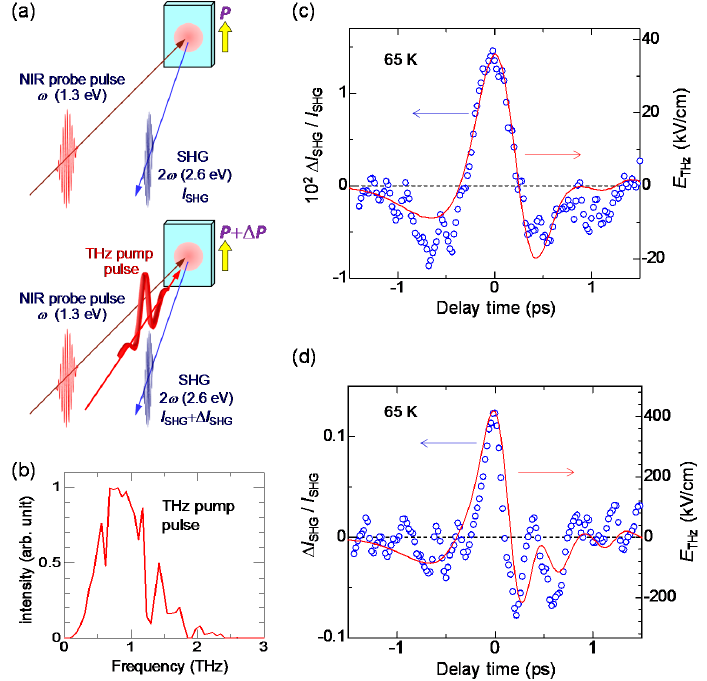
Figure 20. Results of terahertz-pump SHG-probe measurements in the ferroelectric I phase of TTF-CA [41]. ( a ) Schematics of terahertz-pump SHG-probe measurement in the ionic phase; ( b ) a Fourier power spectrum of a terahertz electric-field pulse shown by the red line in; ( c ) time evolutions of changes in an SH intensity ( I SHG − 65K ) at 65 K, ∆ I SHG ( t ) / I SHG − 65K , by a terahertz electric field (blue circles), with the electric-field amplitude of (c) 36 kV/cm; and ( d ) 415 kV/cm. Red lines show electric-field waveforms of terahertz pulses ( E THz ( t )